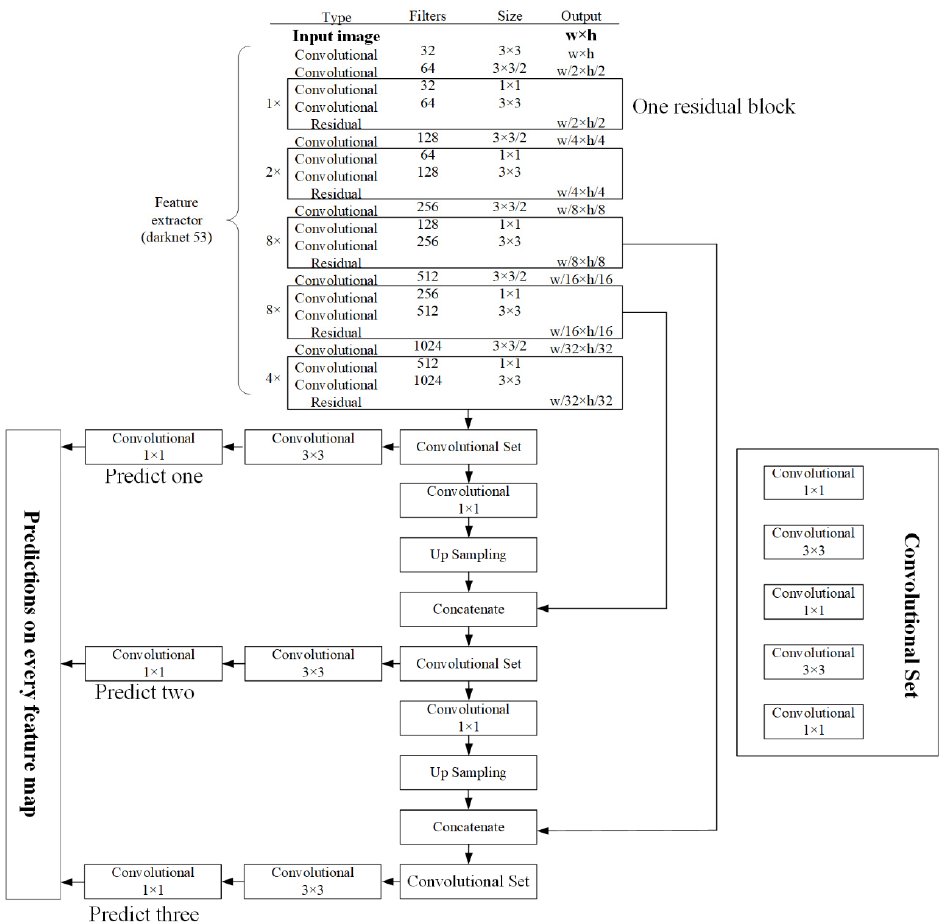
Figure 3. The architecture of the excavator detection model based on You Only Look Once V3 (YOLOv3). It has 75 convolutional layers, with residual layers and upsampling layers. The excavator detection model uses darknet53 as the backbone to extract the features of the input image and detects the excavators on three different scale feature maps [43].